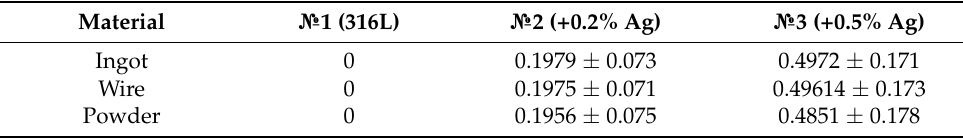
Figure 12. Microhardness of samples determined by the Vickers method. Qualitative and quantitative analysis of the silver content in ingots, wires and powders was carried out on an optical emission spectrometer. Before the tests, the materials were dissolved in aqua regia (25% nitric acid and 75% hydrochloric acid) until a homogeneous solution was obtained. The analysis showed the presence of silver in the samples with silver added, which indicates that the process of producing the spherical powder did not affect the silver content in the samples. The results are presented in Table 5. Table 5. The amount of silver in the compositions (%).